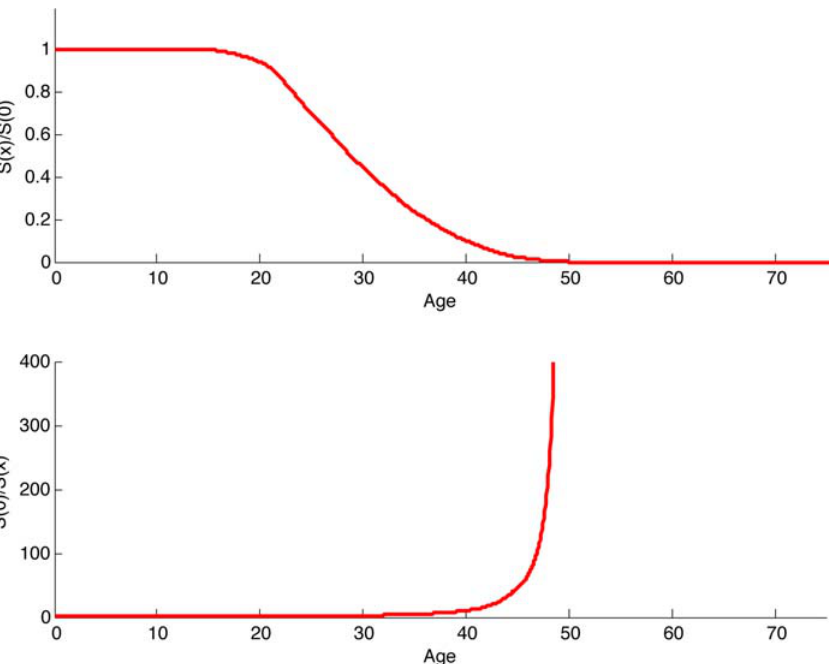
Figure 1. The wall of death. This figure shows the force of selection by age, S ( x ), as a fraction of the force of selection at birth, S (0), as described by Hamilton using female-only demography. ( a ) Hamilton’s one-sex force of selection at age x (shown relative to its value at birth) falls to zero with the decline of remaining survival-weighted female reproduction. b is the inverse of the top panel. In mutation-selection balance, the frequency of deleterious mutant alleles is expected to be proportional to 1/ S , where S is the force of selection for a dominant or semi-dominant allele. The inverse of the force of selection is an indicator of age-specific mortality. The rapid increase in mortality at female menopause is the ‘wall of death.’